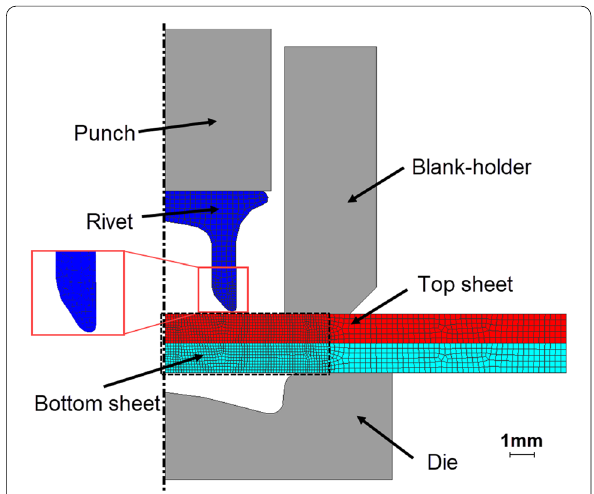
Figure 4 Schematic of the SPR process simulation model